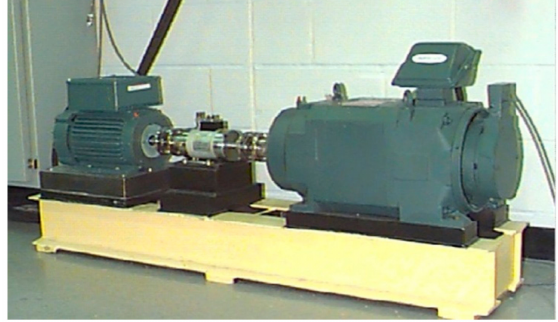
Figure 6. Bearing platform used for experiment.